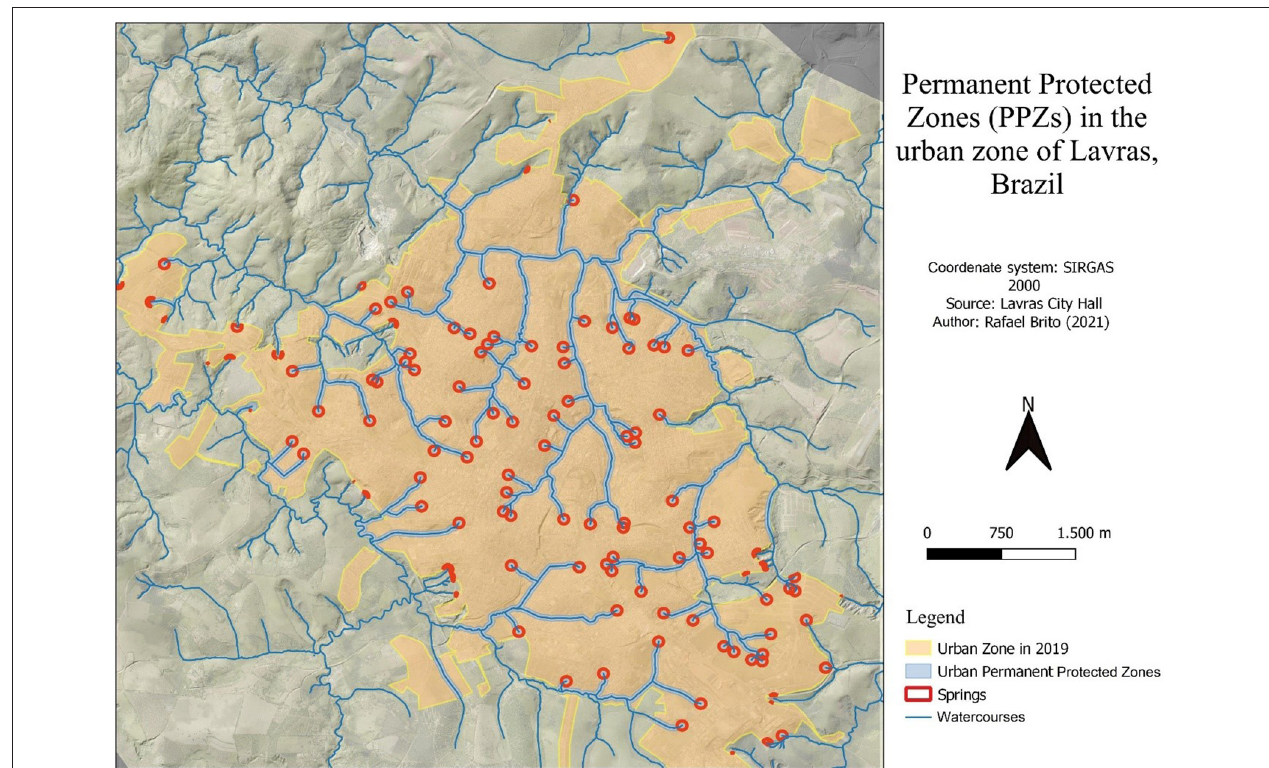
FIGURE 8 | Map of the urbanized perimeter and area referring to the springs and watercourses identified in Lavras-MG. Source: Sousa R. B. et al.